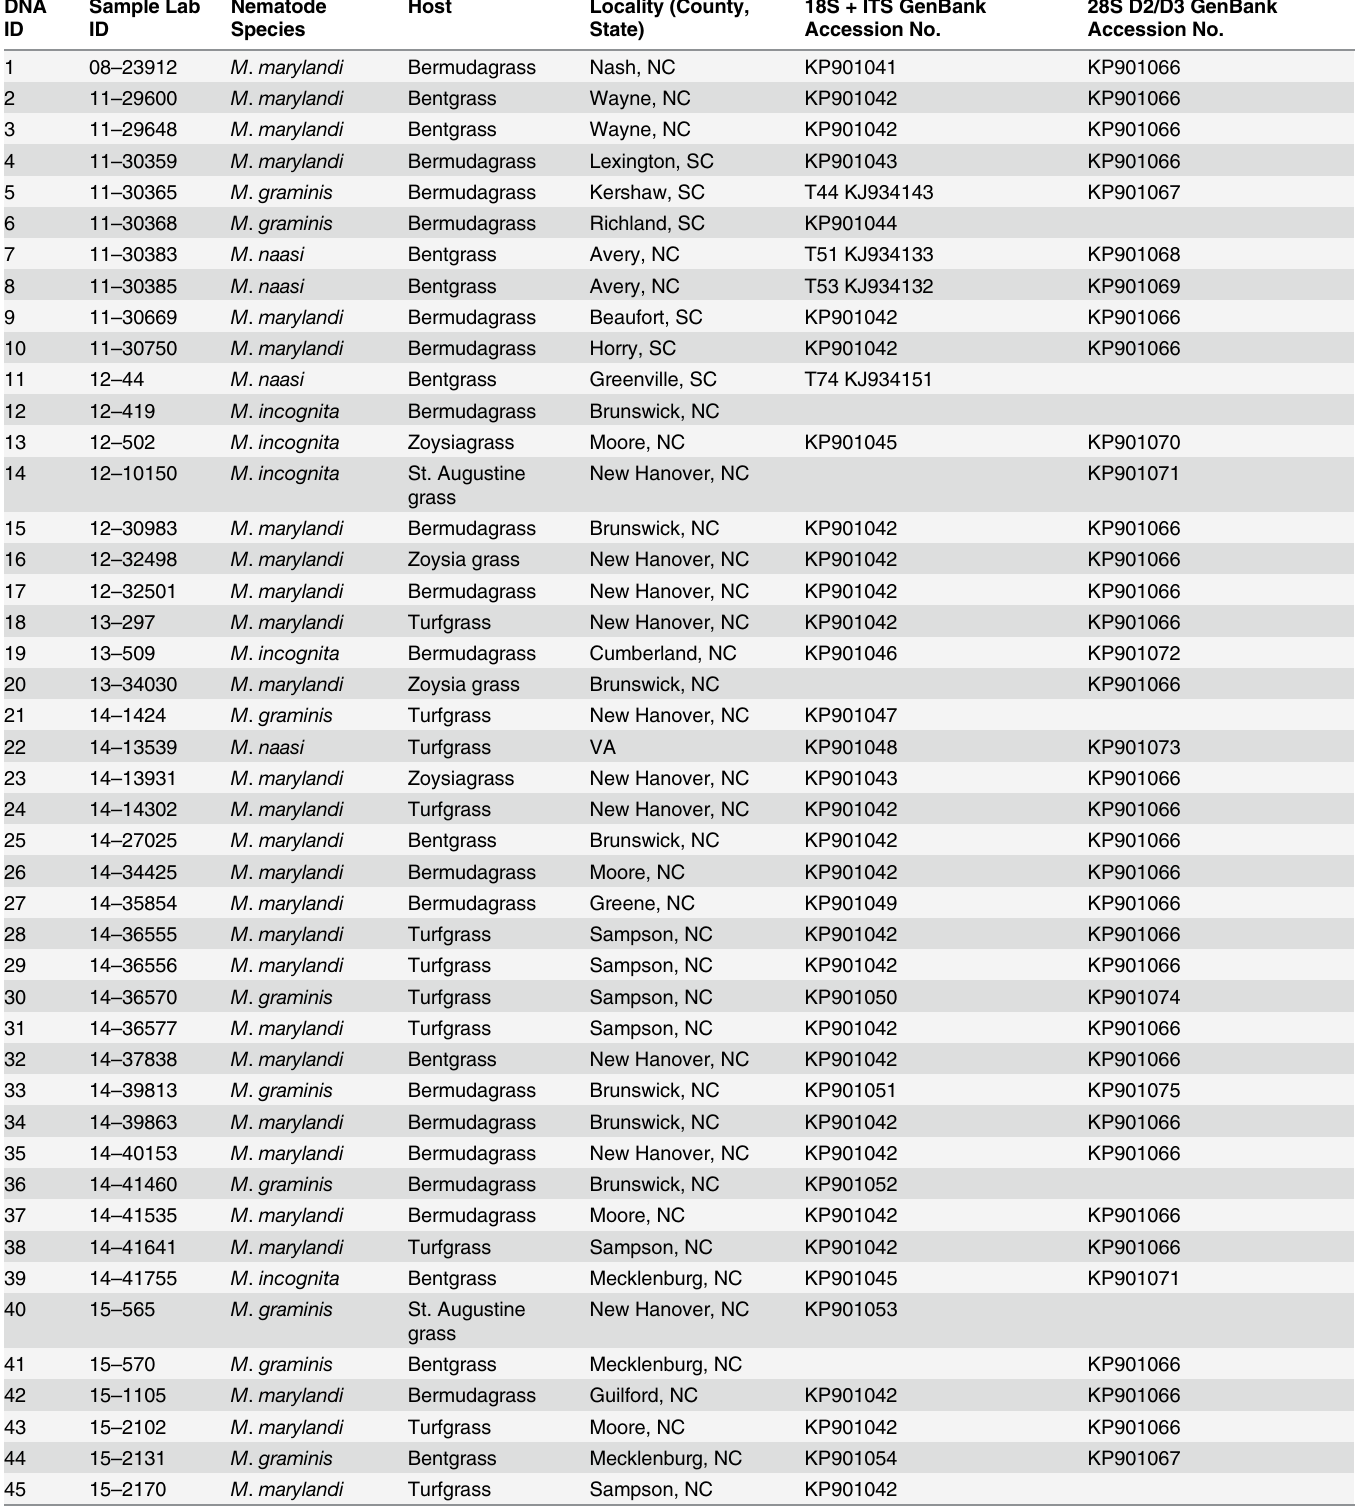
Table 1. Species and isolates of root-knot nematodes sequenced in the present study. DNA